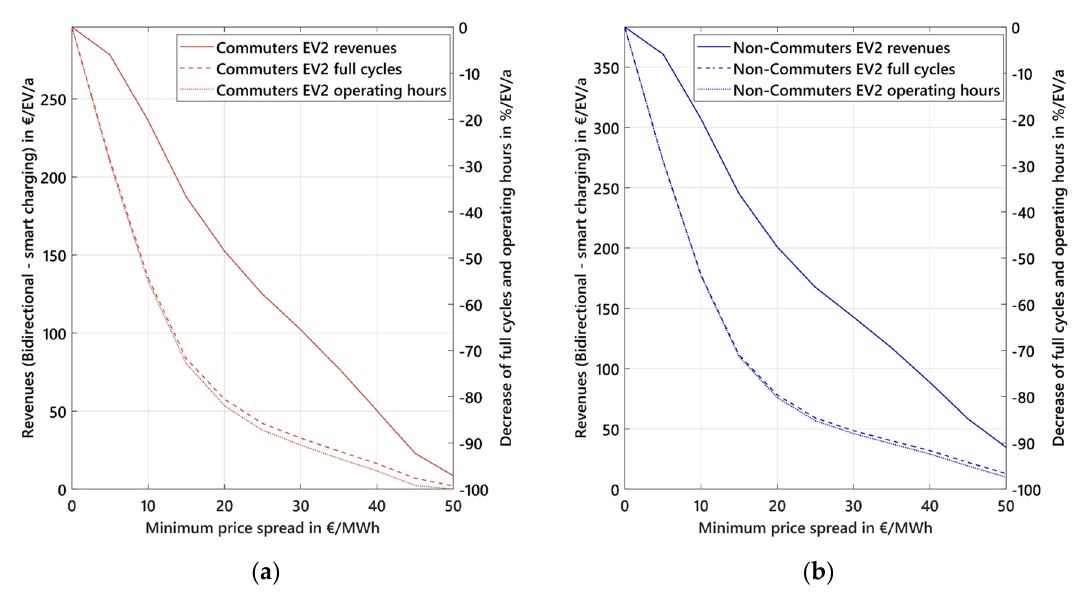
Figure 6. Effect of restricted minimum price spread on revenues, full cycles and operating hours of EV2 for commuters ( a ) and non-commuters ( b ).